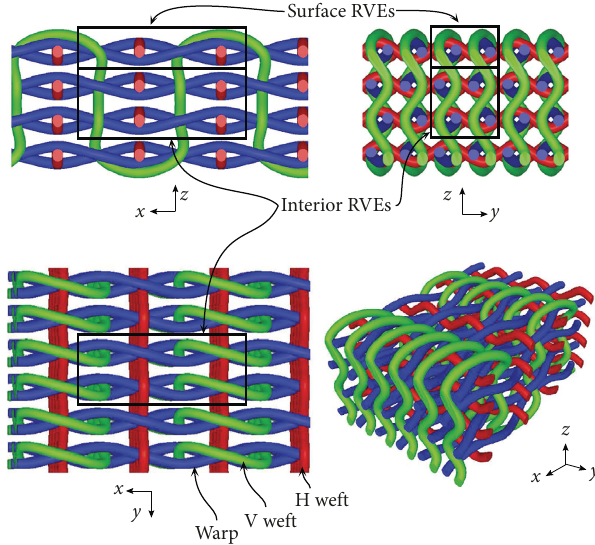
Figure 1: A plain 3D weave, comprising warp, horizontal H, weft and vertical V weft, depicted along its three principal axes and in an isometric view. Surface and interior RVEs of the weave architecture are also